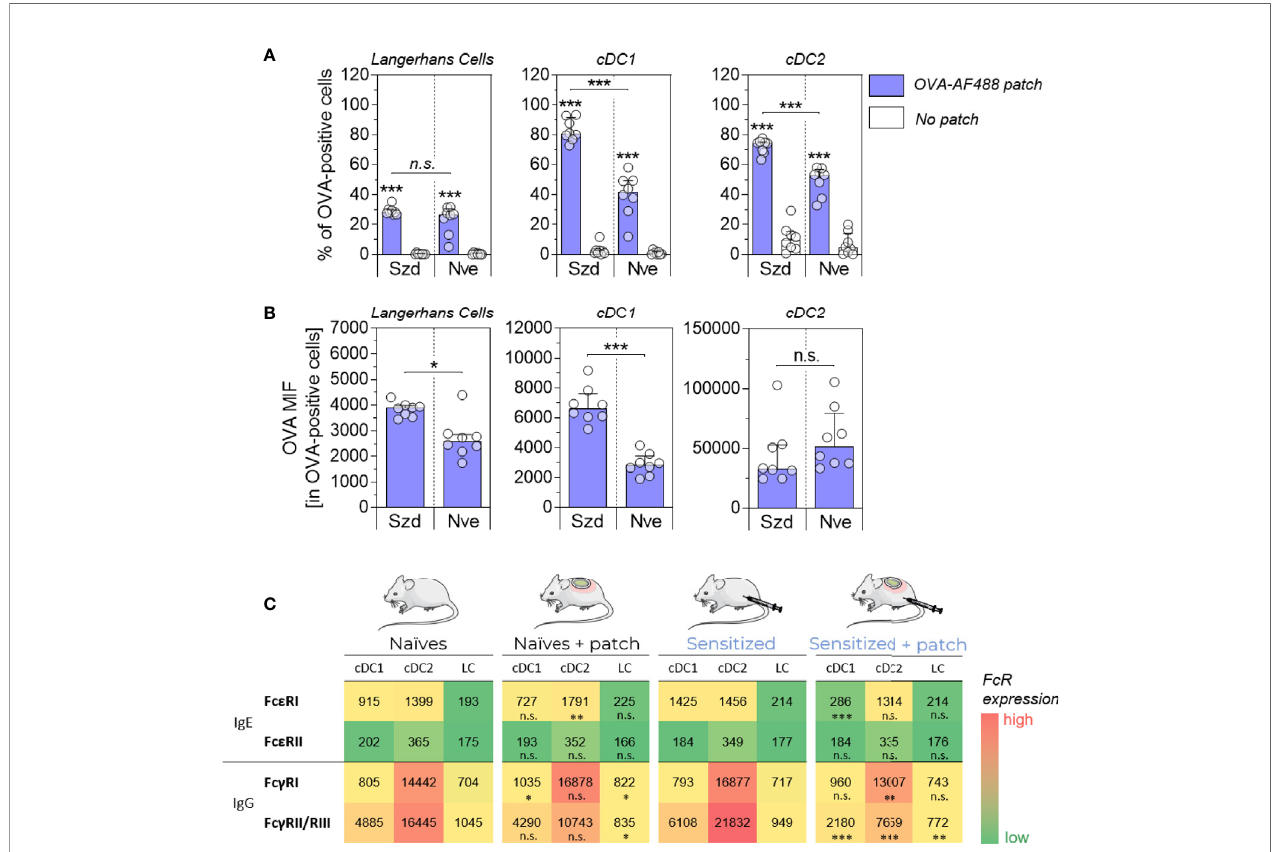
FIGURE 1 | Allergen uptake by skin DC is enhanced in sensitized animals and involves Fc receptors. OVA-sensitized (Szd) or naïve (Nve) mice received a patch containing OVA-AF488 on hair-free skin (depilated) on the back (in blue). As negative controls, mice received no patches (in white). Six hours after patch application, a skin sample corresponding to the patch application area was collected and cells were analyzed by Flow Cytometry. (A) The percentage of OVA-positive cells was measured among Langerhans cells, cDC1 and cDC2, as indicated. (B) The median of OVA fl uorescence intensity (OVA MFI) was measured from OVA-positive DCs. Data are median and interquartile ranges of individual values (N = 8 per group). Data are representative of several independent experiments. (C) The relative expression of Fc receptors was evaluated by measuring MFI. Data are median of individual MFI (N = 8 per group). Fc ϵ RI, Fc ϵ RII and Fc g RII/RIII expression data are representatives of two independent experiments. The level of signi fi cance indicated for sensitized + patch mice was derived from the comparison to sensitized mice. P values were determined using the Mann-Whitney test (*P < 0.05; **P < 0.01; ***P < 0.001; n.s., non-signi fi